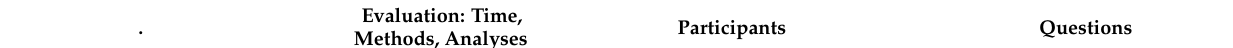
Table 2. Evaluations: methods, time, data-gathering methods, actors, questions, and analyses.